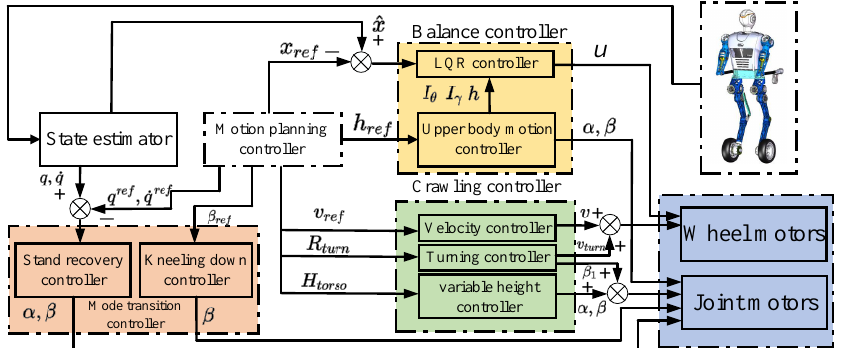
Figure 6. Overview of the controller architecture including two-wheeled balance controller, crawling on four limbs controller and mode transition controller. α = [ α 1 α 2 α 3 ] T is the angle of each joint of the